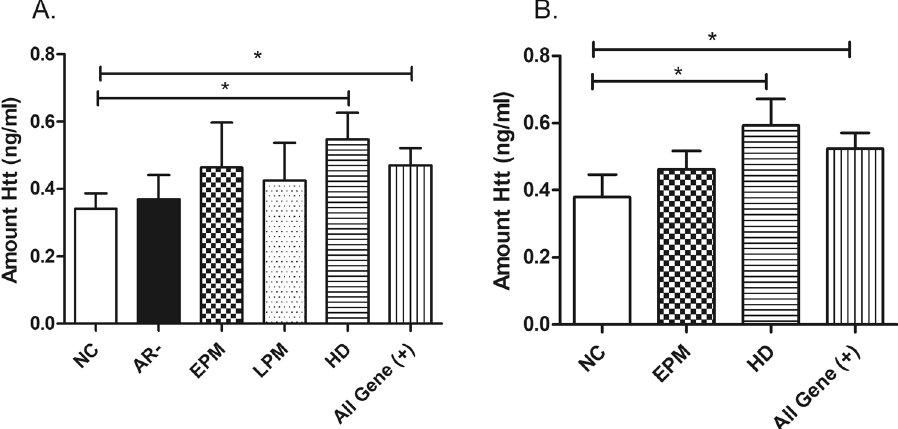
Figure 3. Levels of tHtt are elevated in saliva from HD patients. Total Htt levels (ng/ml) were measured using ELISA in saliva supernatants from five different diagnostic groups: NC = normal control; AR( − ) = at-risk, gene-negative; EPM, Early premanifest; LPM, late pre-manifest; HD = manifest Huntington’s disease. The amount of tHtt (ng/ml) reported is relative to a recombinant Htt protein of 139 amino acids per the ELISA assay. Differences in salivary tHtt levels were determined by One-way ANOVA with a Dunnett’s post-test. * P < 0.05, ** P < 0.01. An initial cohort, Cohort 1, and a validation cohort, Cohort 2, were used for this study (see Table